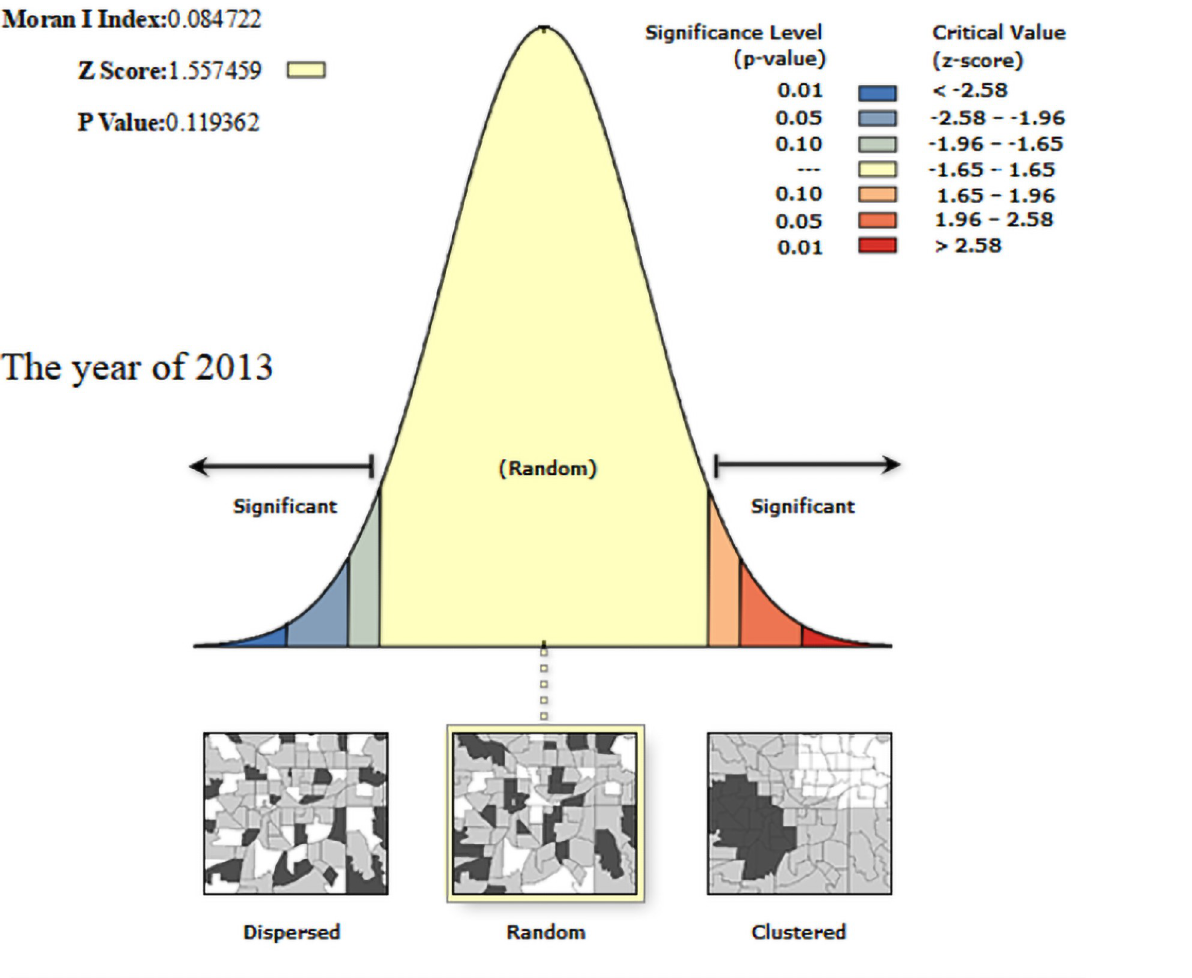
Fig 6. Spatial autocorrelation report of the coordination of the sports industry and health service industry of China in the year of 2013.